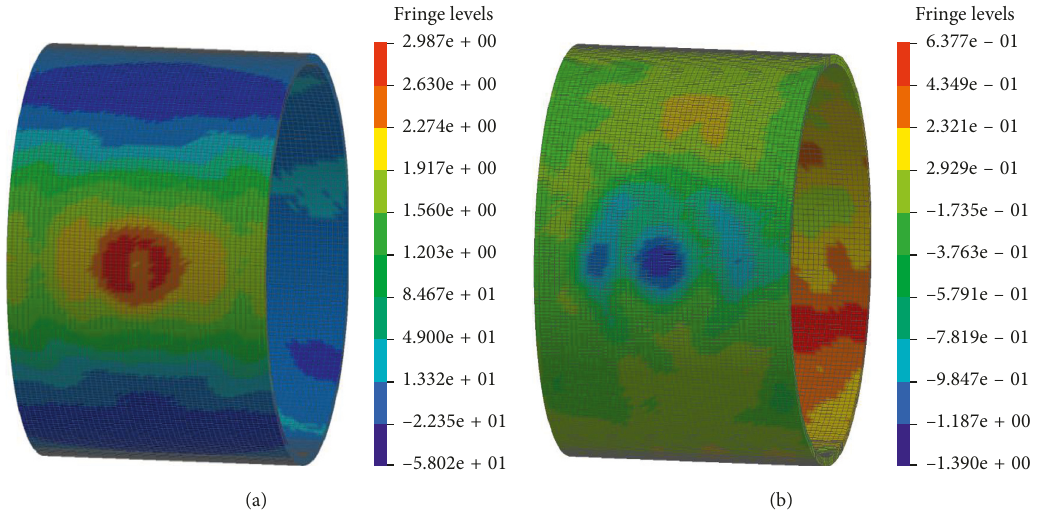
Figure 12: Speed nephograms of point A within 10m. (a) 0.56s nephogram; (b) 0.62s nephogram.